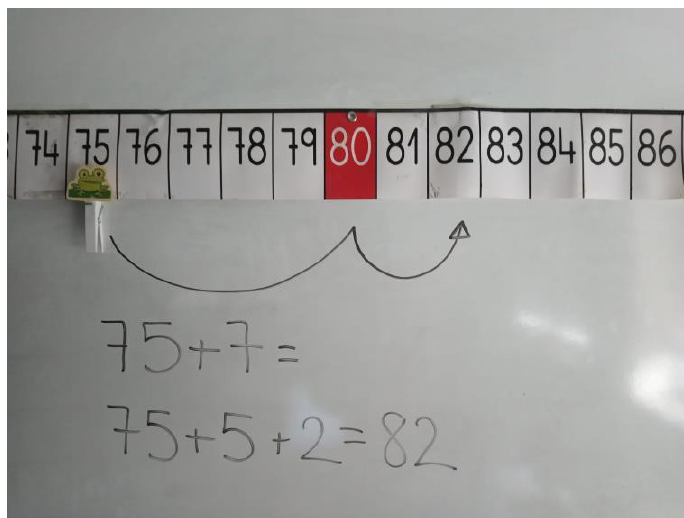
Figure 29. Saltarina’s jump represented in a symbolic way.